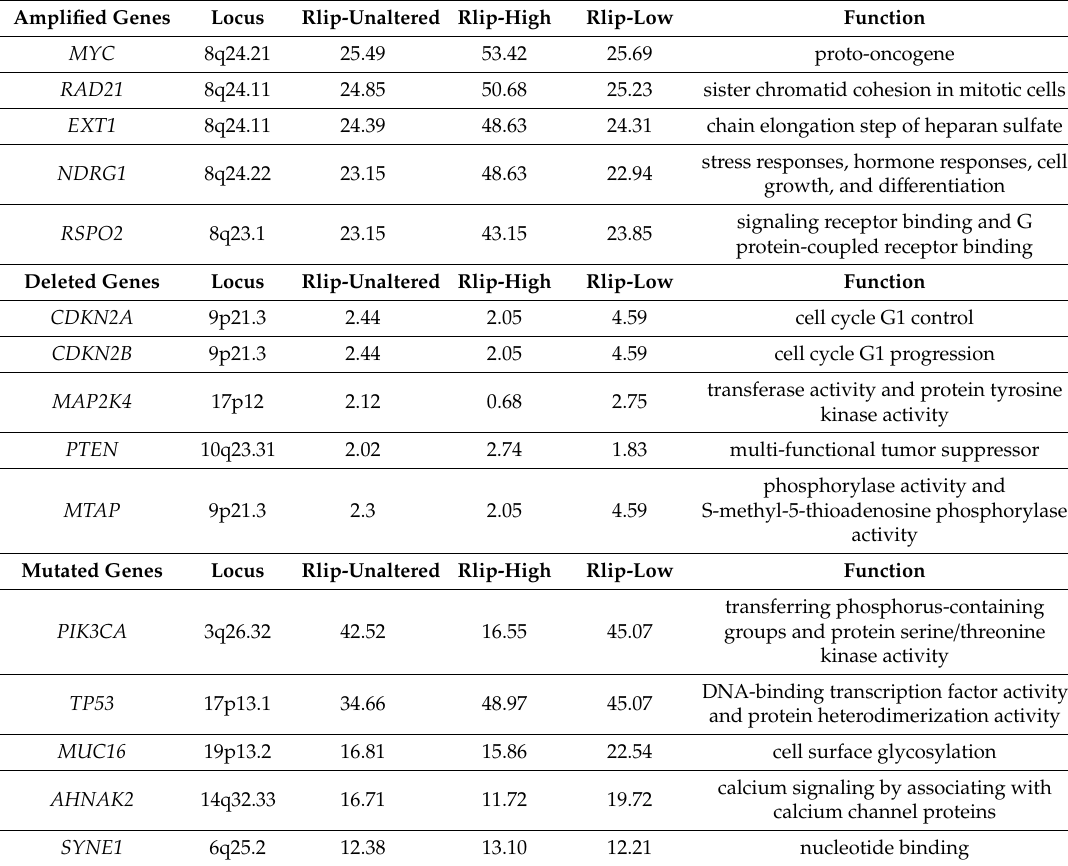
Table 1. Correlation between Rlip expression level and alterations in key signaling pathway genes in breast